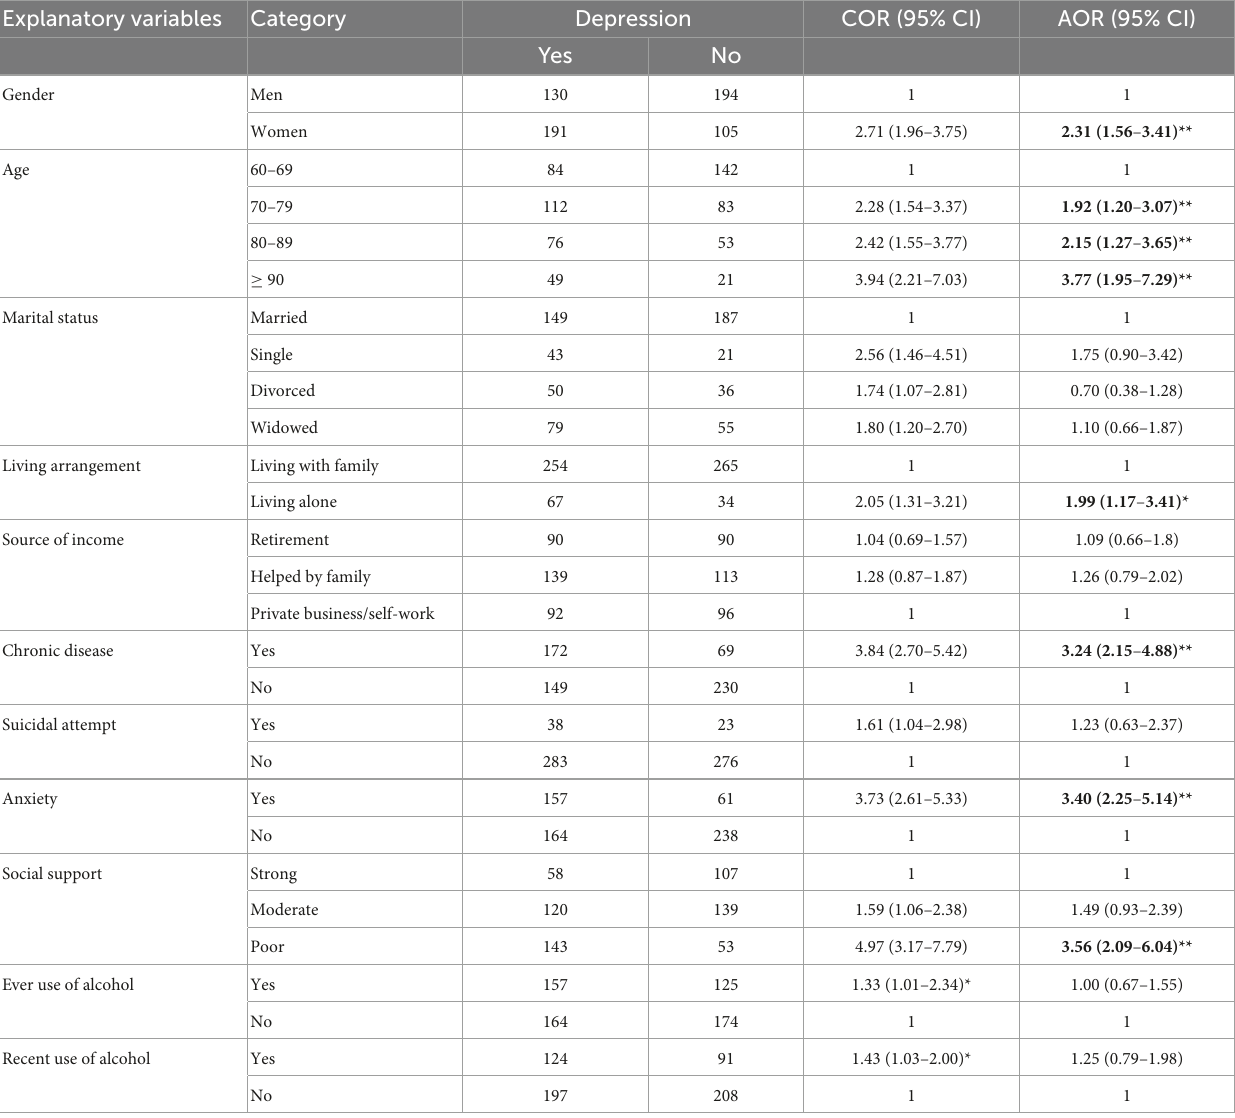
TABLE 4 Bivariate and multivariate logistic regression analysis of factors associated with depression among older adults in Yirgalem town Southern Ethiopia, 2022 ( n = 620). Explanatory variables